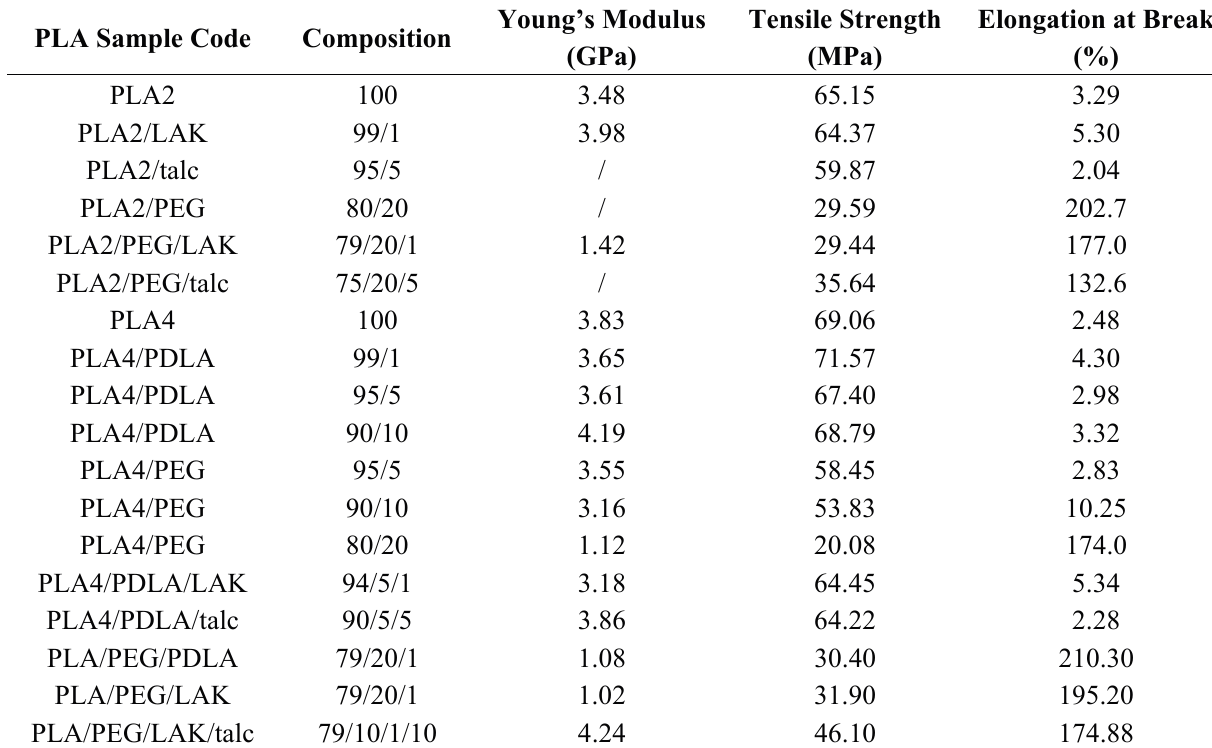
Table 2. Mechanical properties of PLA